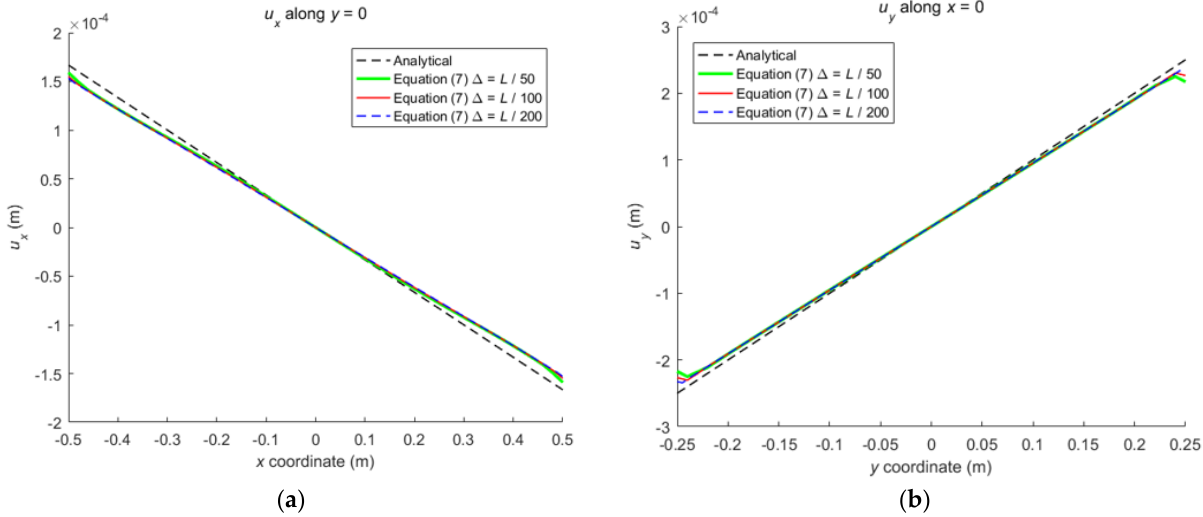
Figure 4. The displacement along central lines of the rectangular plate: ( a ) u x along y = 0; ( b ) u y along x = 0.